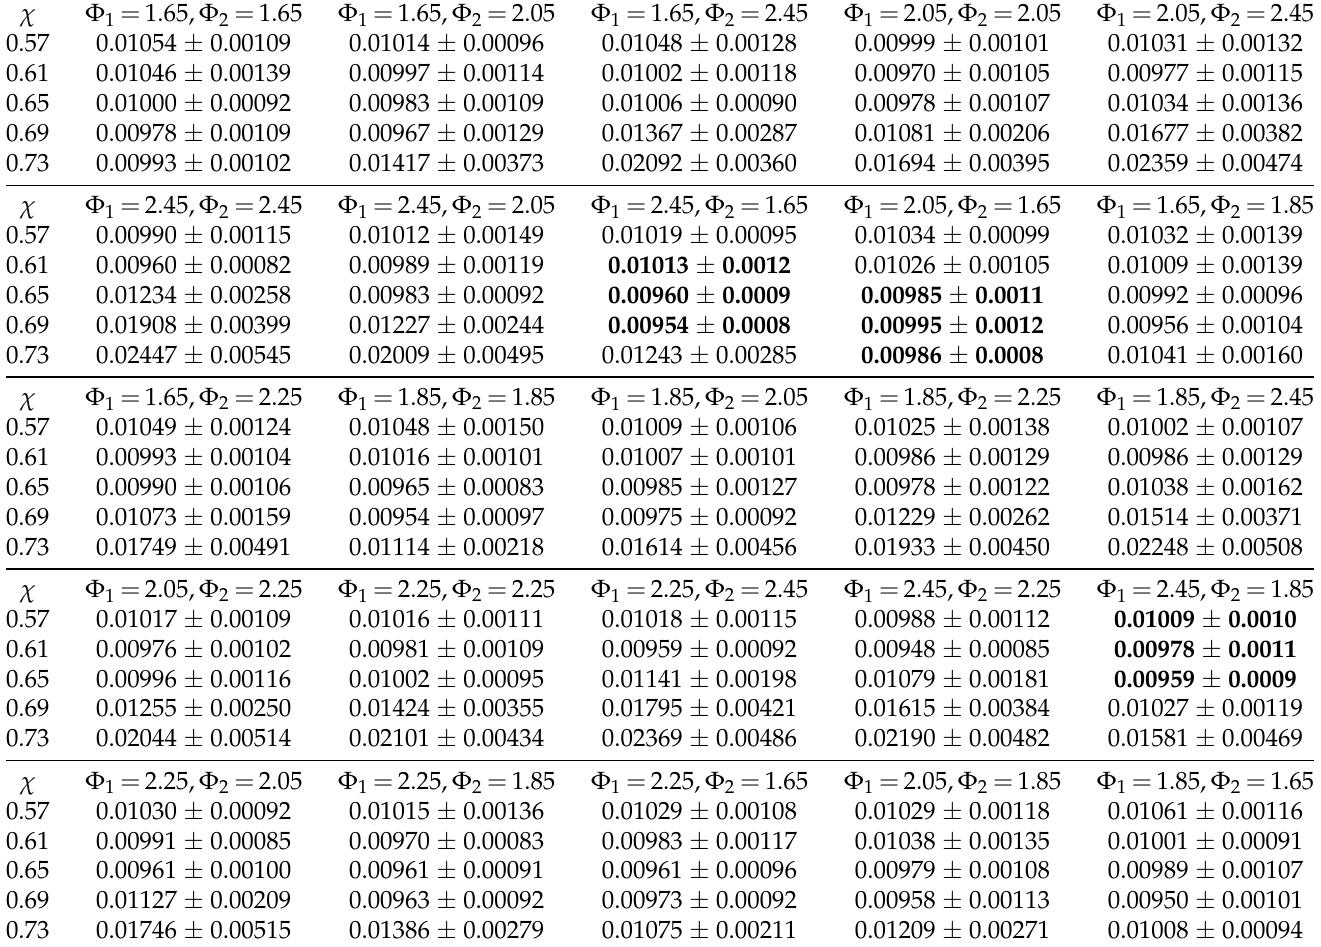
Table 3. The values of mean and standard deviation of f 1 obtained using PSO with I = 100, D = 80, (cid:96) = 12, n = 25 for 50 calculations with the metric d 3